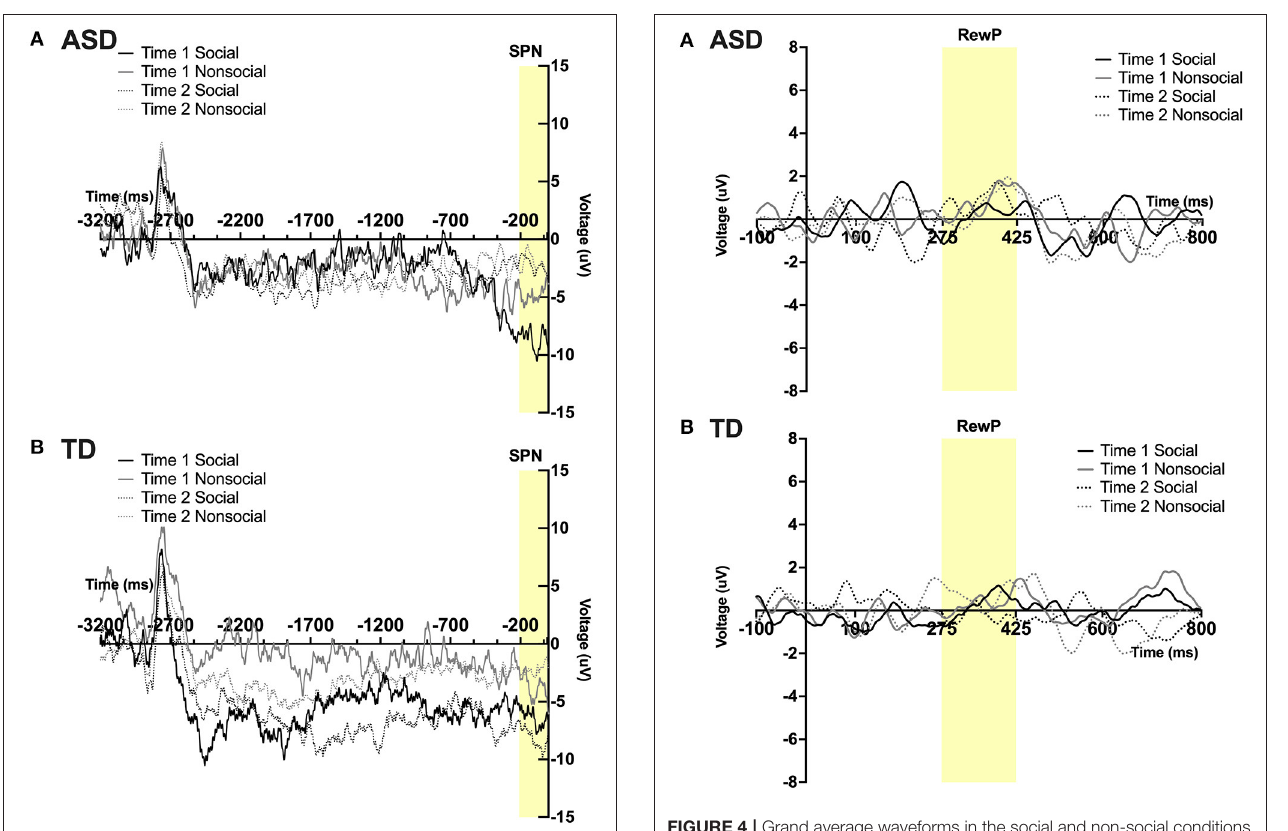
FIGURE 4 | Grand average waveforms in the social and non-social conditions at Time 1 and Time 2 from Reward Positivity (RewP) ERP in (A) ASD participants and (B) TD participants. Note that for this figure, ERPs were filtered using a 25Hz low-pass